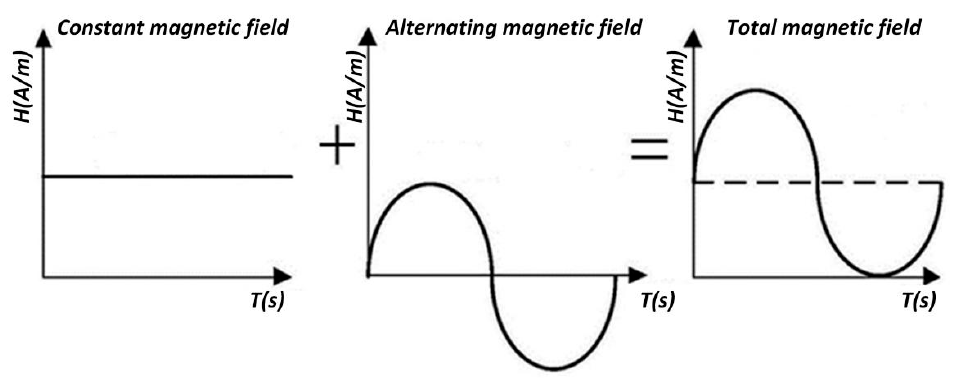
Figure 5. Role of permanent magnets.